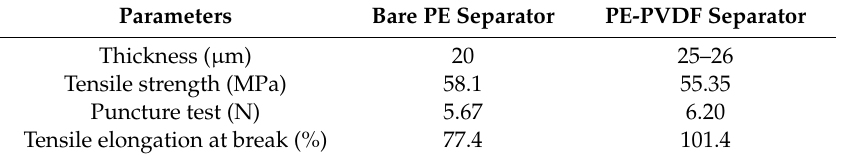
Table 2. Thickness, tensile strength, puncture test and elongation data of separator samples.